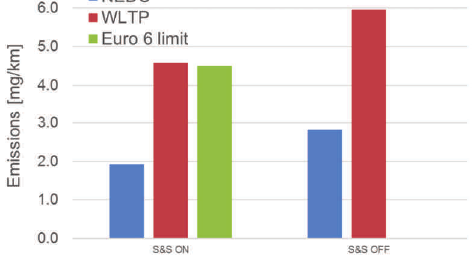
Fig. 1. PM emissions from vehicle 1